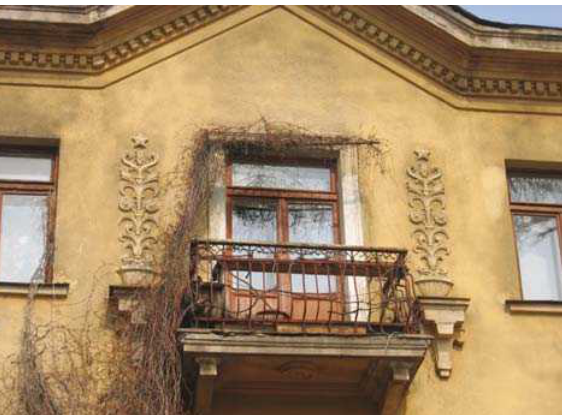
Fig 1. Ornamentation in the style of socialist realism. Kaunas, Girstupis st